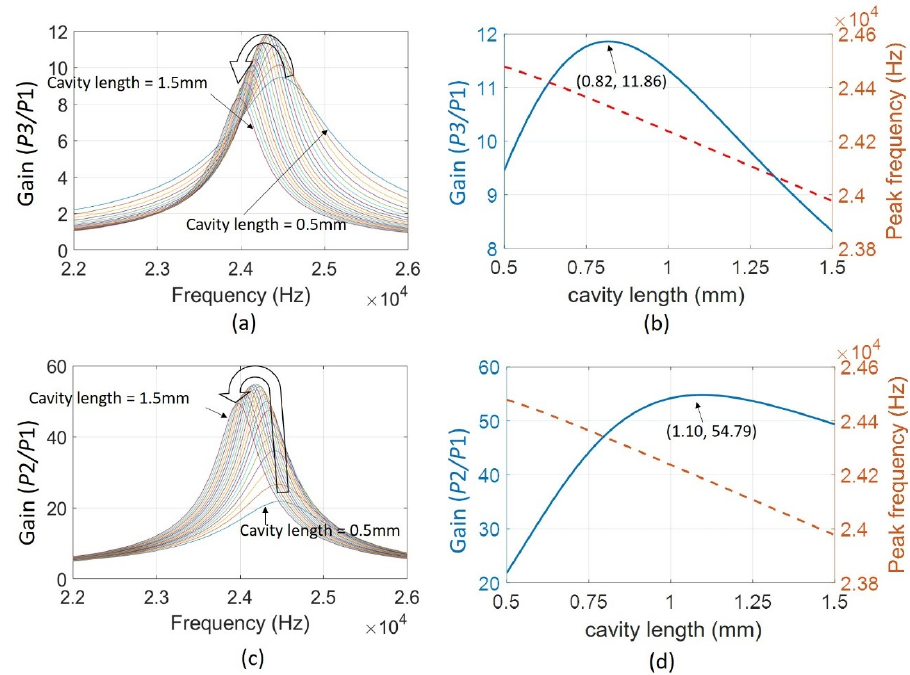
Figure 17. Calculated results of sound pressure gain and peak frequencies as a function of cavity length based on the modified Helmholtz resonator model for ( a ) and ( b ) device emitted to the surrounding; ( c ) and ( d ) inside the Helmholtz cavity.